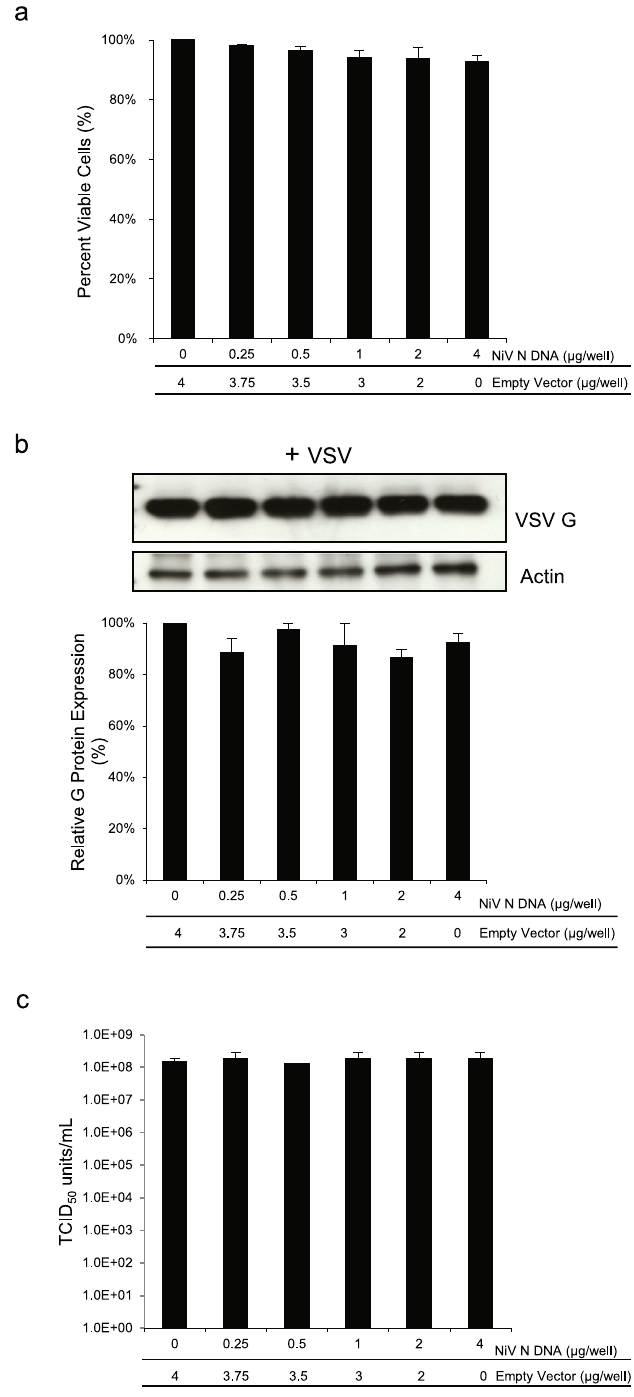
Figure 4. Effects of increasing expression of NiV N on cell viability and VSV replication. Cells were transfected with increasing amounts of plasmid DNA encoding the NiV N gene for 48 hours. Following transfection, ( a ) an XTT assay was performed to assess cell viability and a parallel set of cells were infected with VSV at an MOI of 1 for 24 hours. ( b ) Total cell protein was harvested to quantitate expression of VSV G by western blot and ( c ) supernatants were harvested for titration of viral loads. Western blots were quantified by densitometry and normalized to actin. All experiments were done in triplicate and standard deviations of the mean were calculated. Blots have been cropped to ease